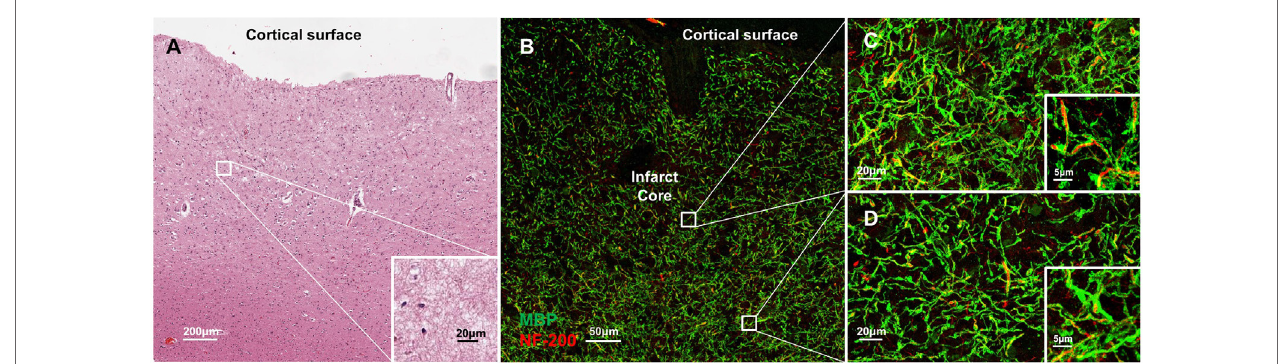
FigUre 4 | Molecular disorganization of axons adjacent to microinfarct exists in the absence of significant changes in structural integrity of myelin and axons. Cortical tissue containing a microinfarct (a) stained for myelin basic protein (MBP, green) and neurofilament 200 (NF200, red) demonstrates very few demyelinated axons adjacent to the infarct core (b) . Co-localization of MBP and NF200 indicates preservation of the structural organization of myelinated axons in regions both immediately adjacent to the infarct core (c) as well as some distance from the infarct core where disrupted axonal microdomain organization was observed (D) . Inset: magnification × 60, scale bar = 5